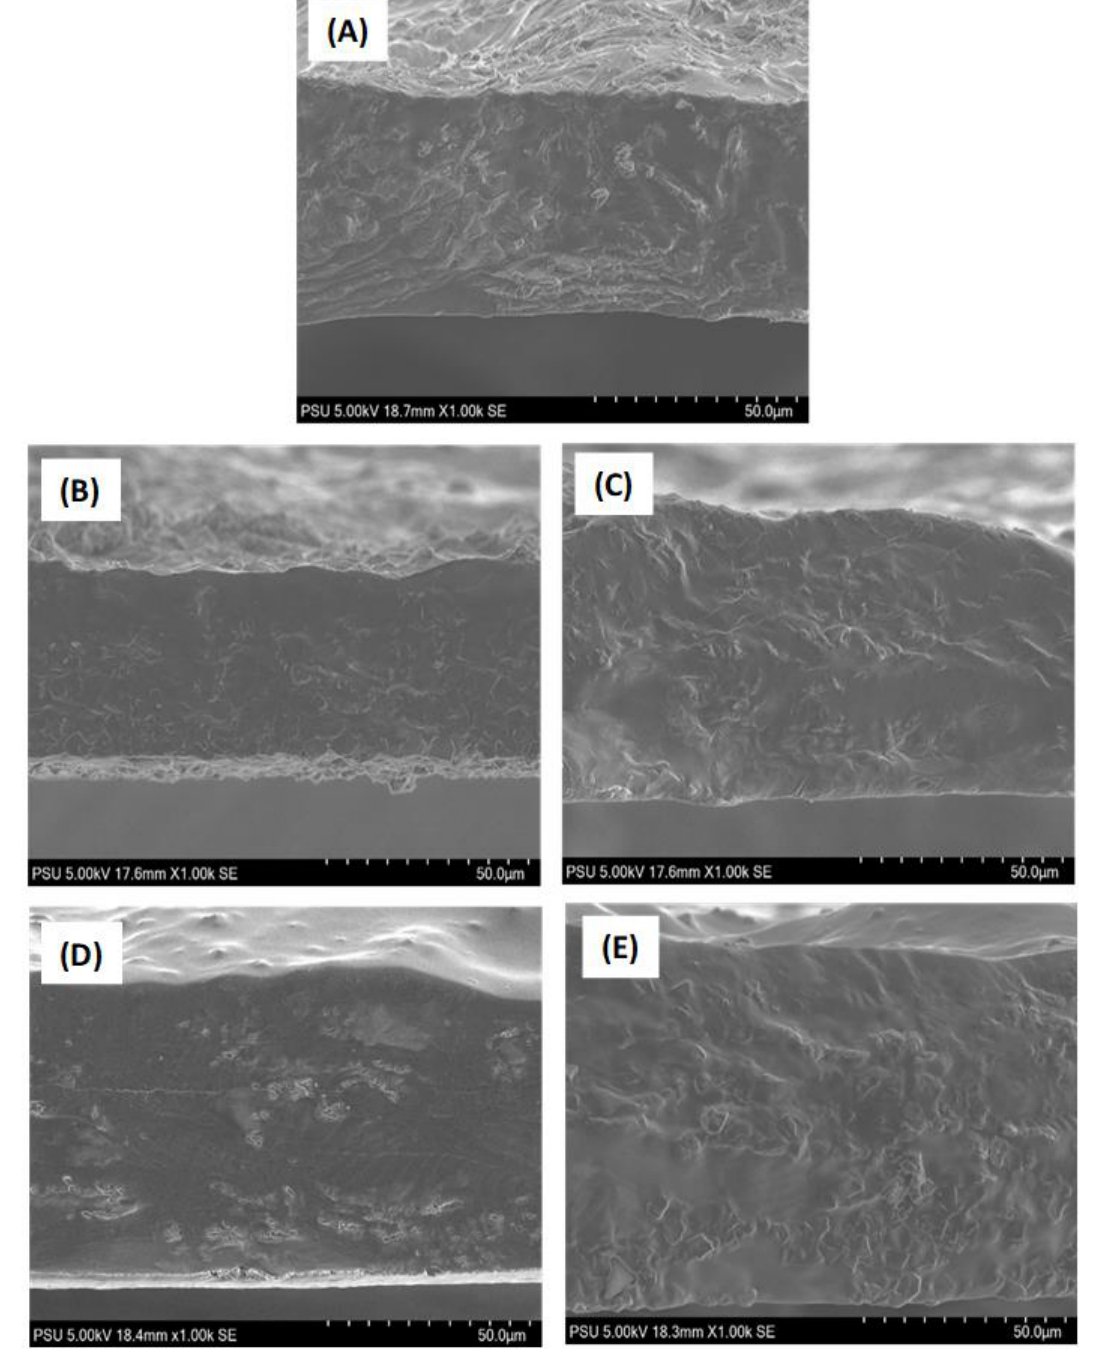
Figure 7. Microstructural observation of the cross-sections ( A – E ) of chitosan–NGRS based edible film incorporated with and without EOs. ( A ) represents control film; ( B ) represents garlic oil added film; ( C ) represents galangal oil added film; ( D ) represents turmeric oil added film; ( E ) represents kaffir lime oil added film.